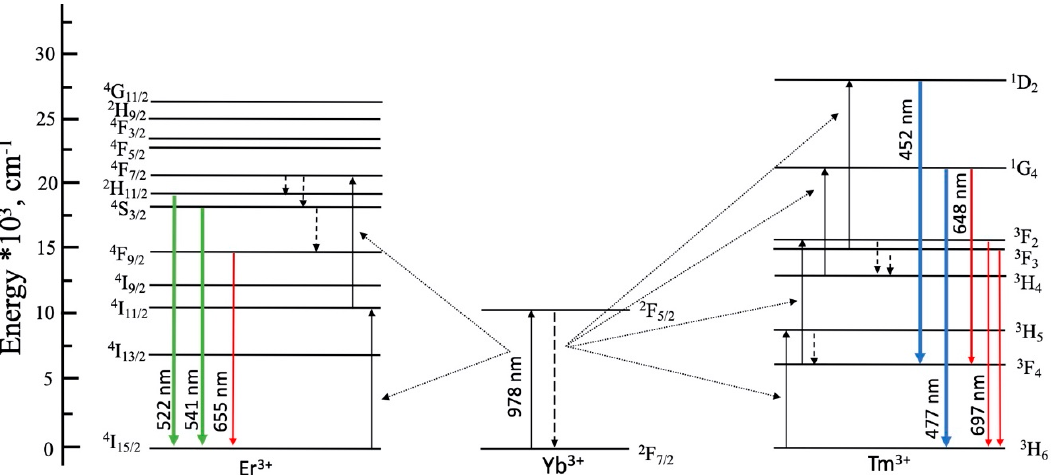
Figure 7. Schematic energy level diagrams of Yb 3+ , Tm 3+ , Er 3+ , and possible upconversion emission processes upon 980 nm excitation.